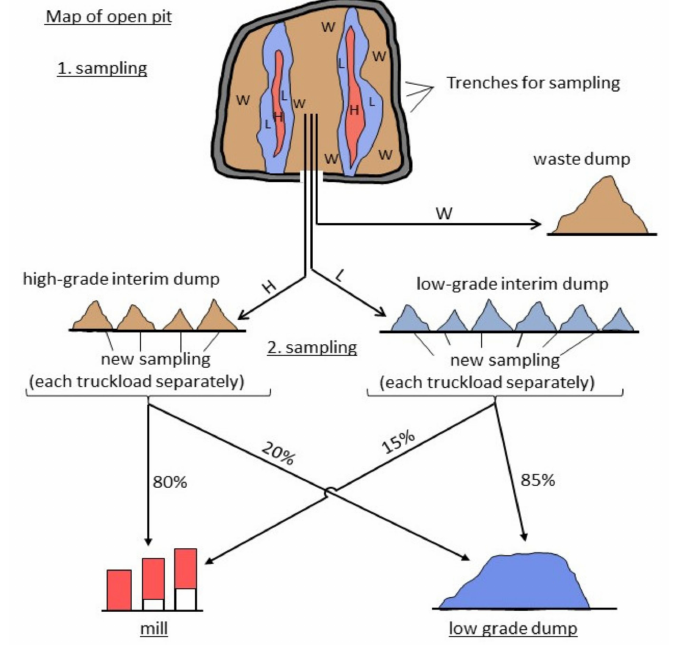
Figure 8. Principle of selective gold-mining open pits in Australia (after 29) (H = high grade ore, L = low grade ore, W =